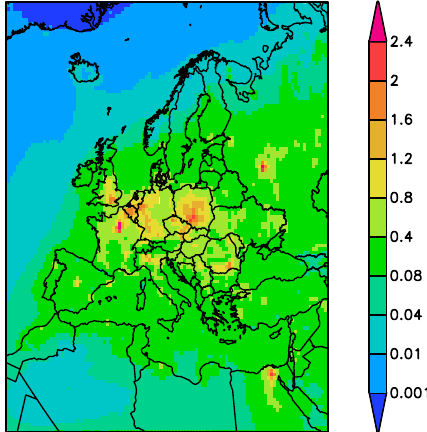
Fig. 1. The model domain covers the entirety of Europe. The colour scheme represents the modelled yearly mean black carbon concen- trations [ µ g/m 3